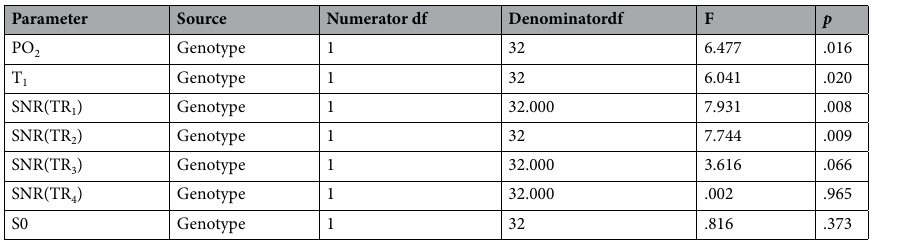
Table 2. Linear mixed-effect modeling results at 30% oxygen. Tests of fixed effects (factor genotype) for PO 2 , T 1 , SNR and S 0 . More detailed statistical parameters including estimates and confidence intervals can be found in the open data